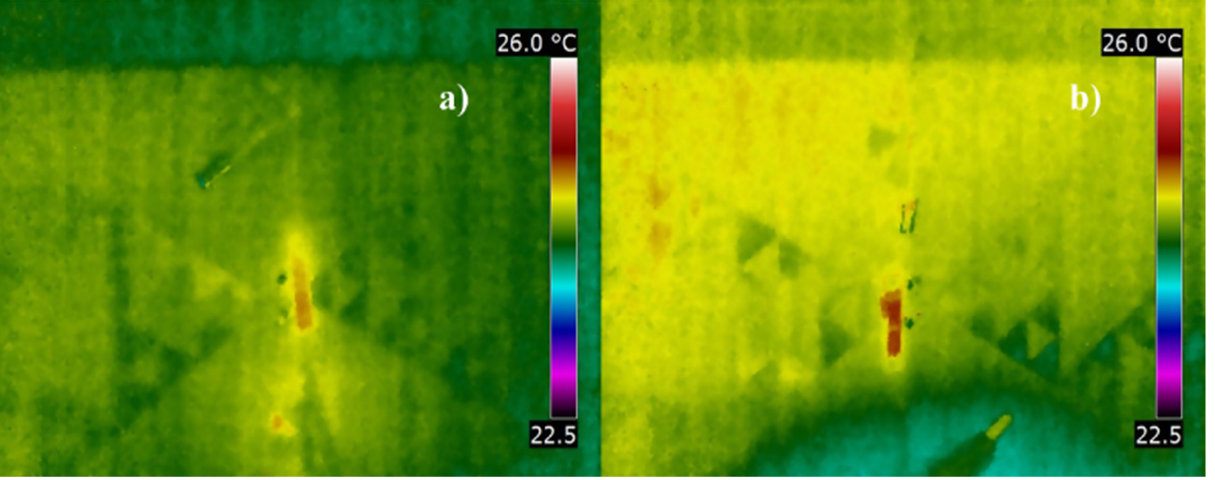
Figure 4. IR thermographs taken at the frequency of 554.5 MHz for: ( a ) AUT-coupled SWCNT uncracked bolometer and ( b ) AUT-coupled SWCNT cracked bolometer. The central red rectangles in ( a , b ) correspond to the SWCNT films coupled to the antenna.